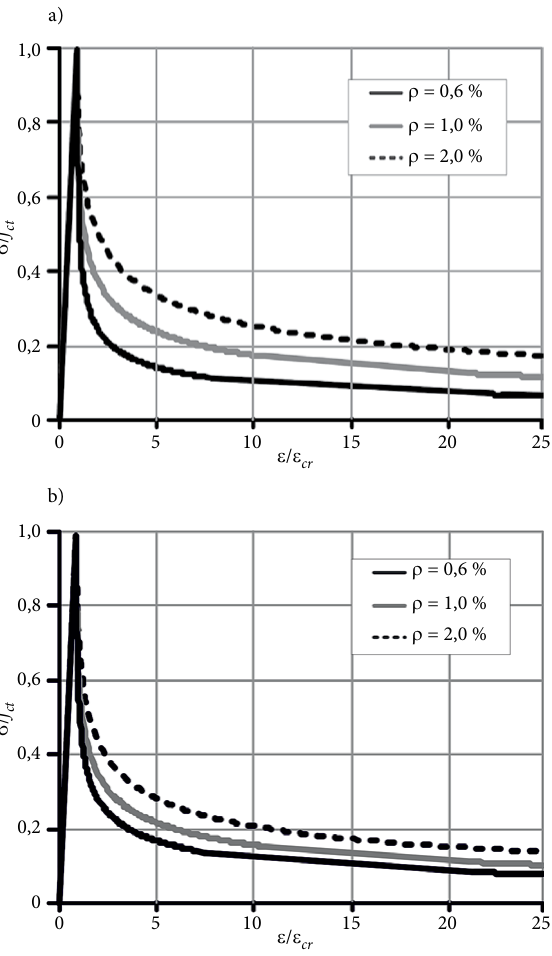
6 pav. Skaitiškai nustatytos betono tempiamojo sustandėjimo diagramos, kintant betono klasei: a - r = 1,0 %; b - r = 2,0 % Fig. 6. Numerically derived tension stiffening diagrams for a varying grade of concrete: a - r = 1,0 %, b - r = 2,0